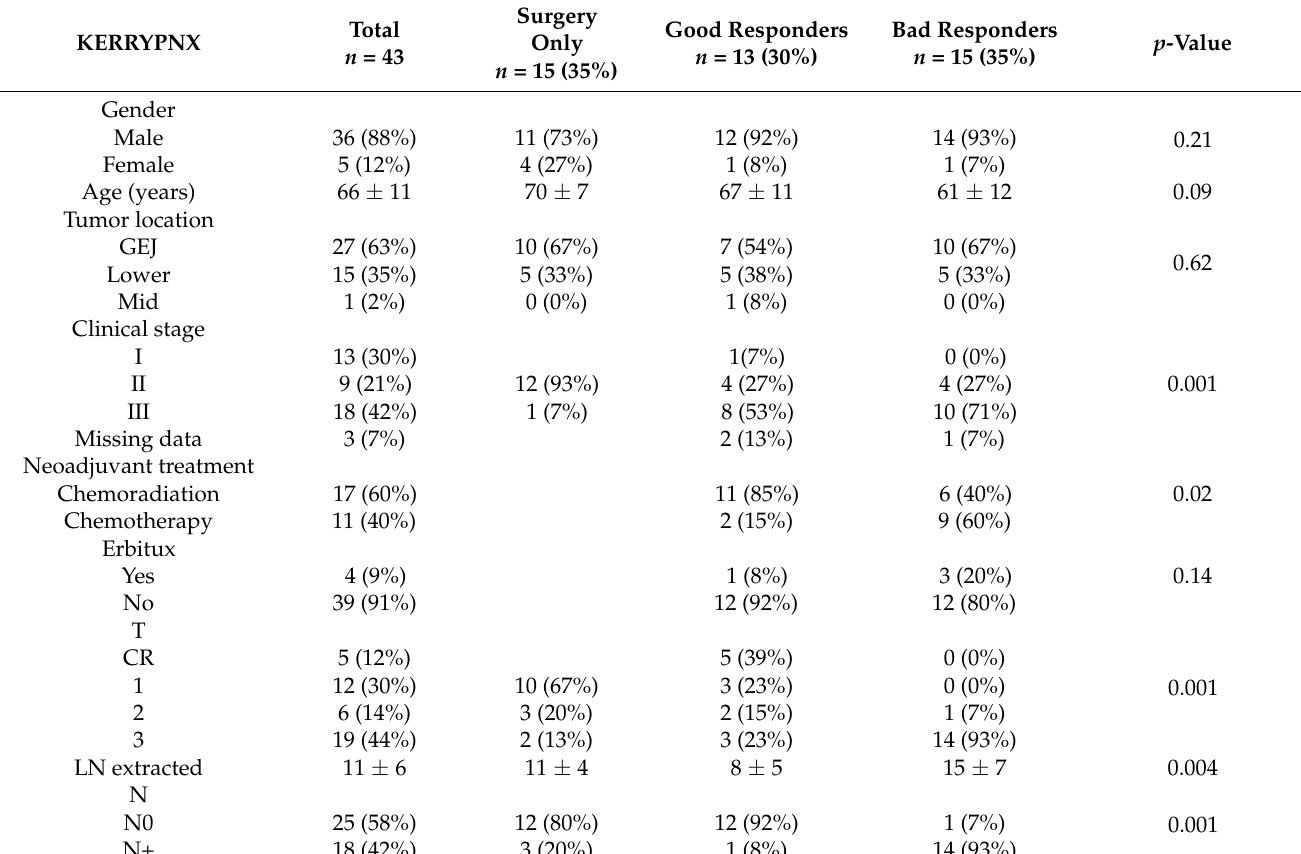
Table 1. Patients’ clinical